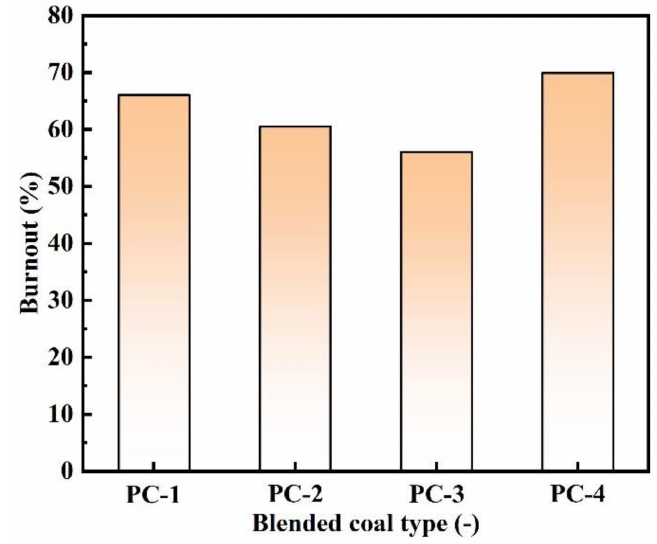
Figure 14. Variation of pulverized coal burnout with different ratios of